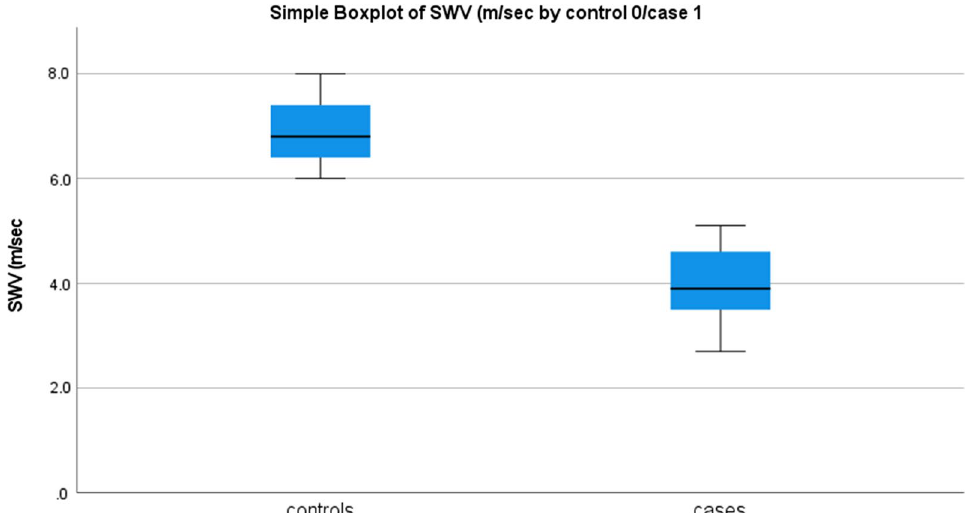
Fig. 4 Difference in SWV between cases and